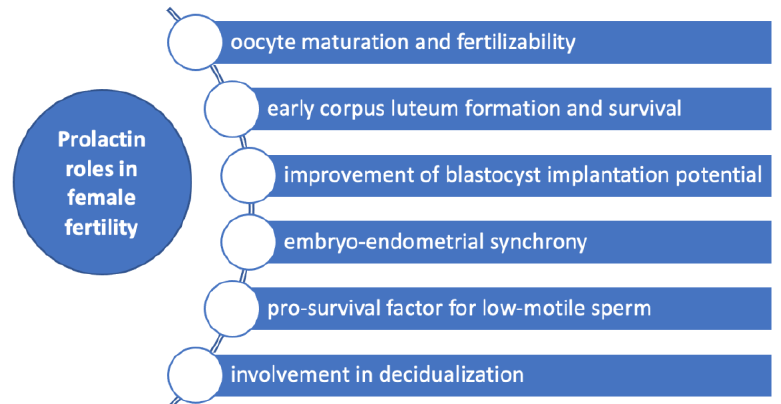
Figure 3. Prolactin roles in female fertility. Prolactin has several roles in female fertility by influencing oocytes maturation and fertilizability, early corpus luteum formation and survival, improvement of blastocyst implantation potential, decidualization, embryo-endometrial synchrony and acting as a pro-survival factor for low-motile sperm.